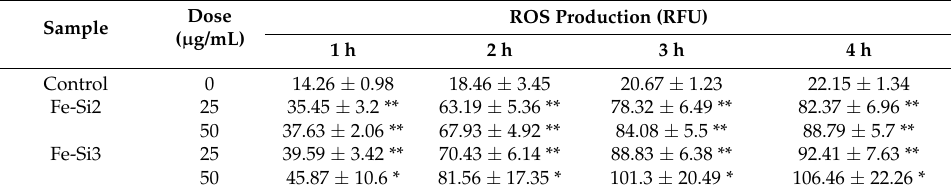
Table 5. Intracellular ROS formation in the presence of hybrid Fe-Si NPs in Caco2 cells. Results are expressed as mean relative fluorescence units (RFU) ± SD of three independent experiments. * p < 0.05; ** p < 0.01 versus